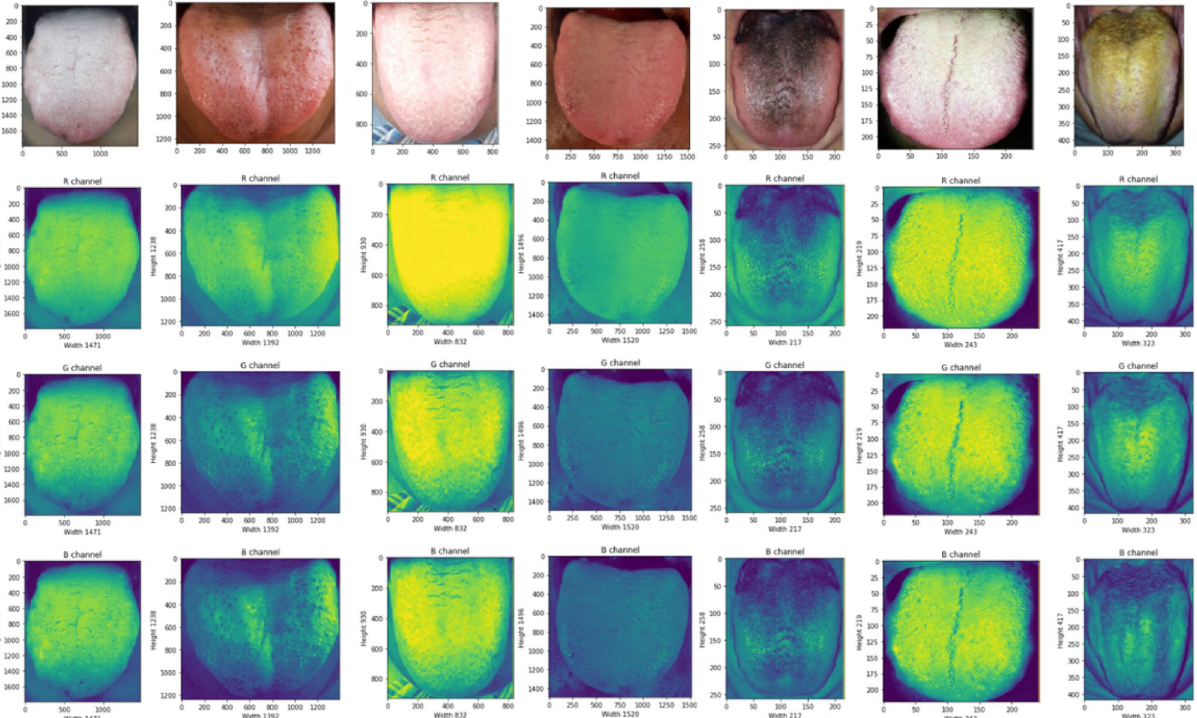
Figure 4. RGB channels for few sample of panoramic tongue images.